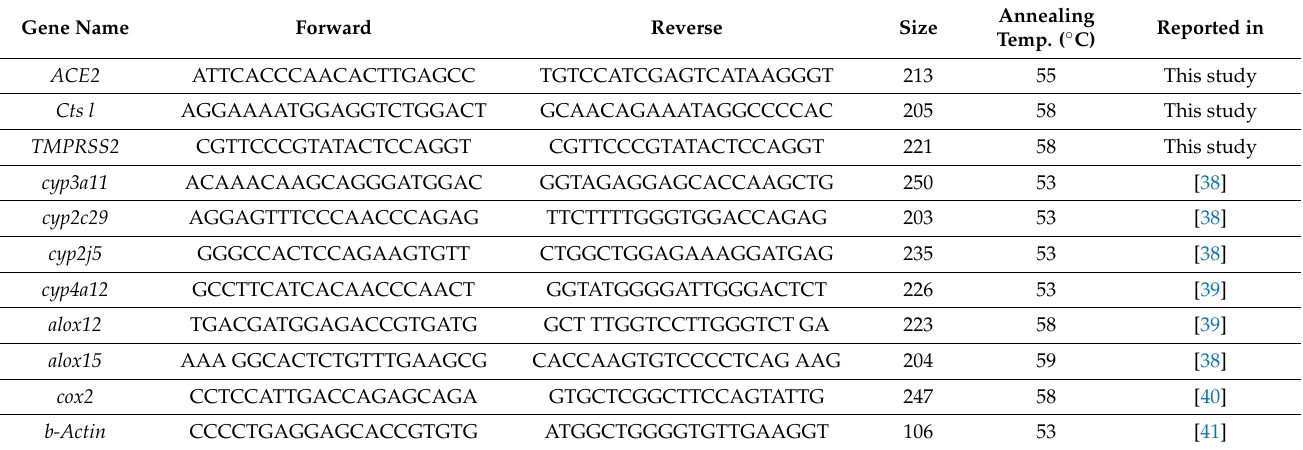
Table 1. The oligonucleotide sequence, amplicon size, and annealing temperature of mouse